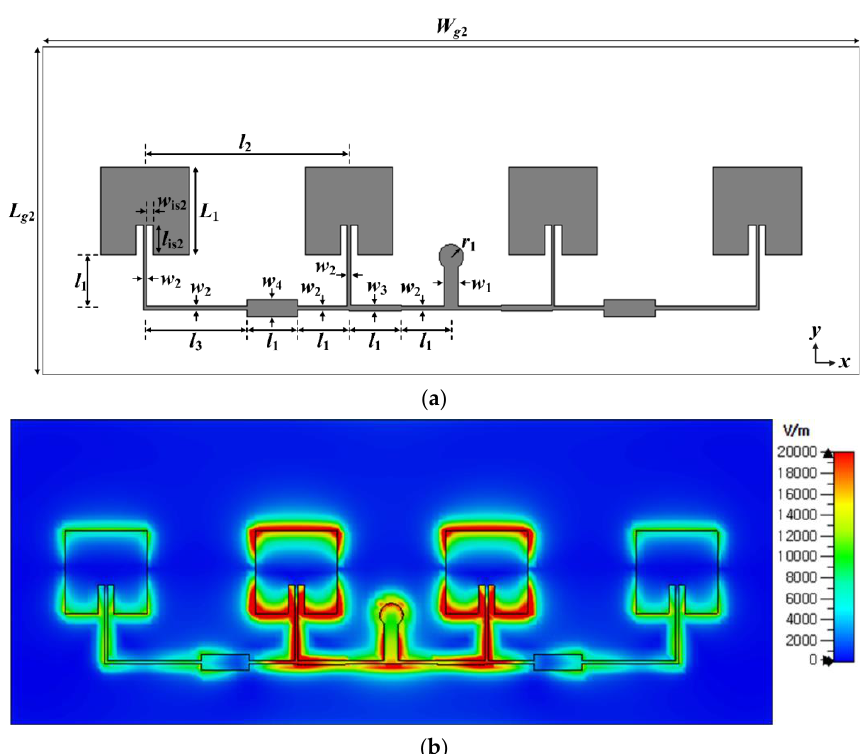
Figure 5. Design and electric field distribution of the 4 × 1 microstrip square patch array antenna combined with a shunt-connected series feed networks using a tapered power distribution: ( a ) the geometry and ( b ) the electric field distribution at 24.125 GHz.